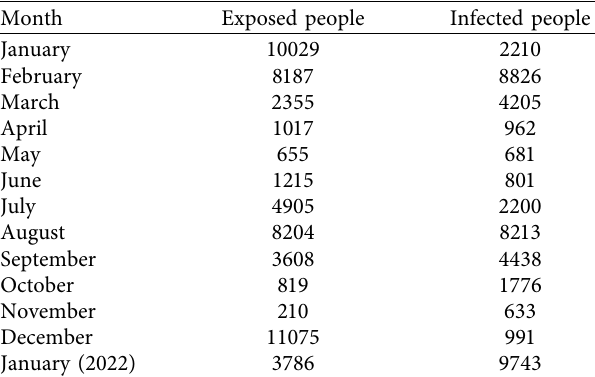
Table 2: Exposed and infected people from January 2021 to January 2022.